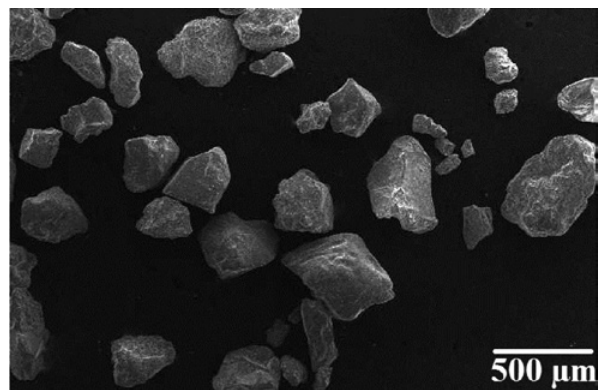
Figure 3: Silica sand abrasive